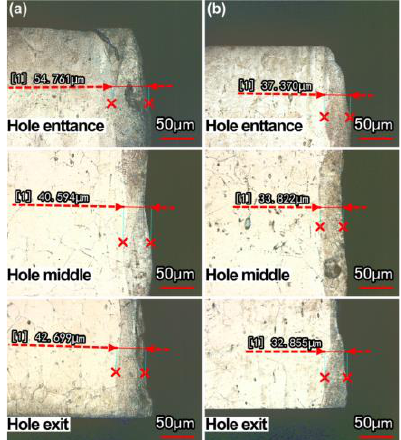
Figure 13. Thickness of recast layer at different locations of hole sidewall: ( a ) in air, ( b ) water − based assistance.